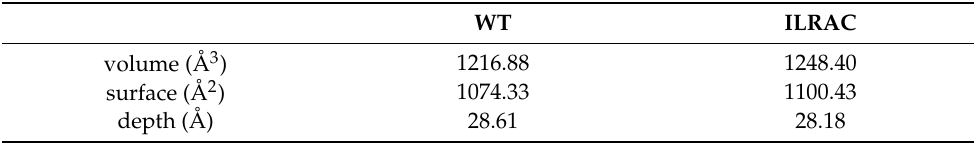
Figure 7. ( A , B ) Substrate binding pocket of wild-type and mutant ILRAC. ( C , D ) Change in the residue interactions around the 223rd residue. ( E , F ) Change in the residue interactions around the 325th residue. Table 5. The size and shape description of substrate binding